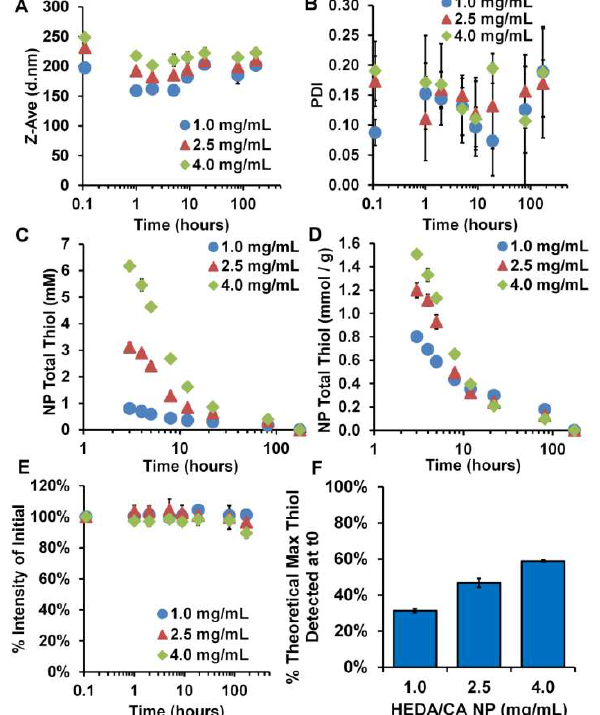
Figure 4. Kinetics plots of HEDA/CA nanoparticles in PBS/EDTA/EDTA. ( A ) z -average diameter, ( B ) polydispersity index (PDI), ( C ) total thiol found, ( D ) total thiol found per mass of nanoparticles, ( E ) % intensity of dispersion over time, and ( F ) % of the theoretical maximum thiol concentration found after washing. n = 3, M ± SD.